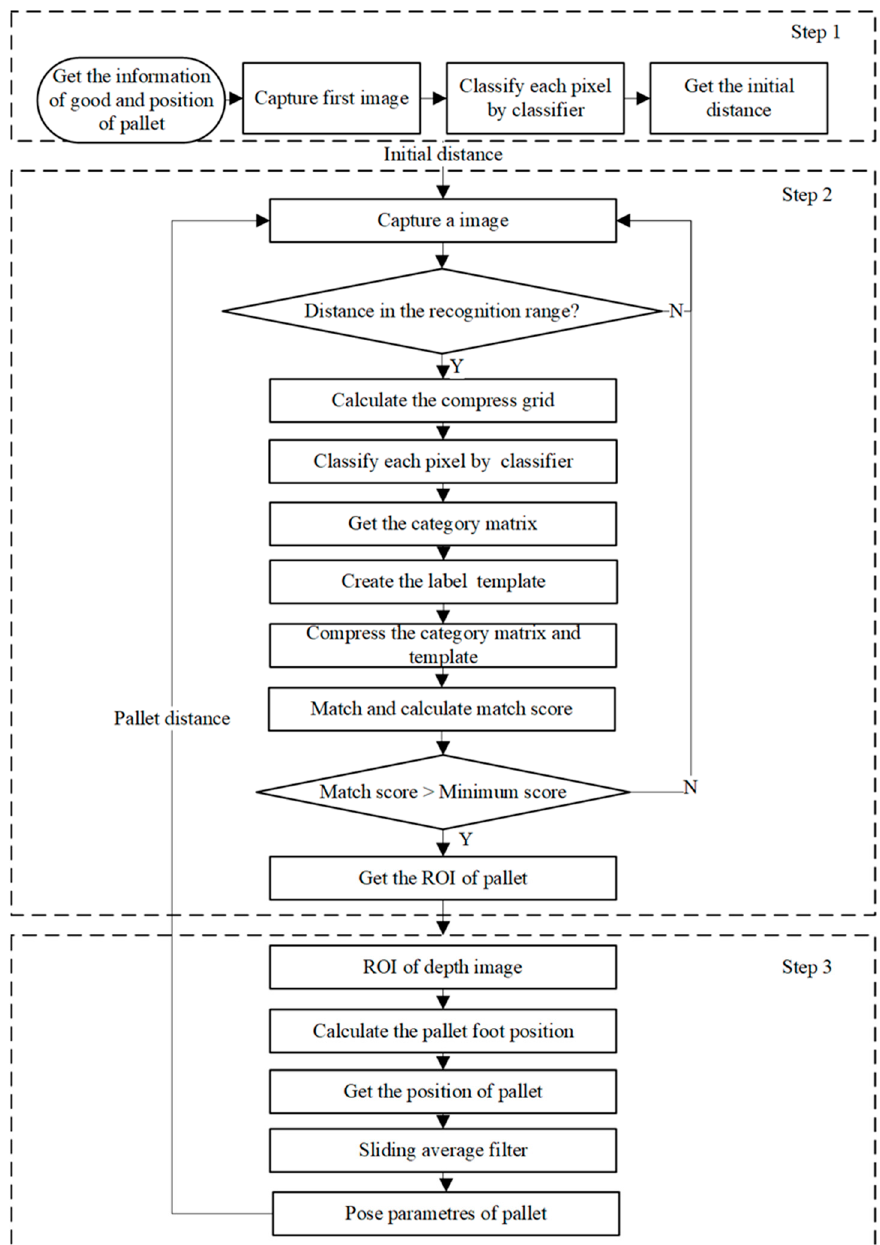
Figure 2. Flow chart of the proposed algorithm.